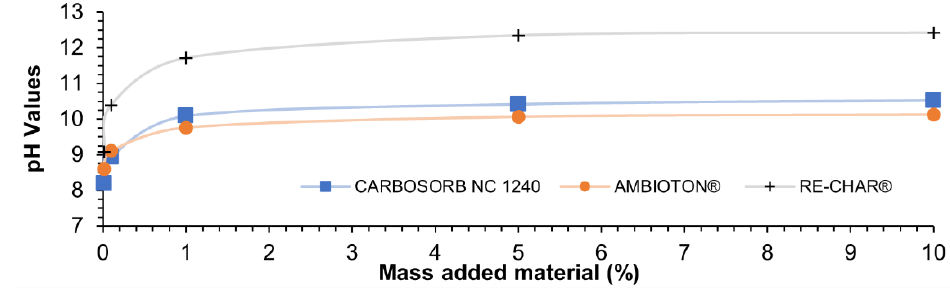
Figure 11. pH as a function of the added material (%).